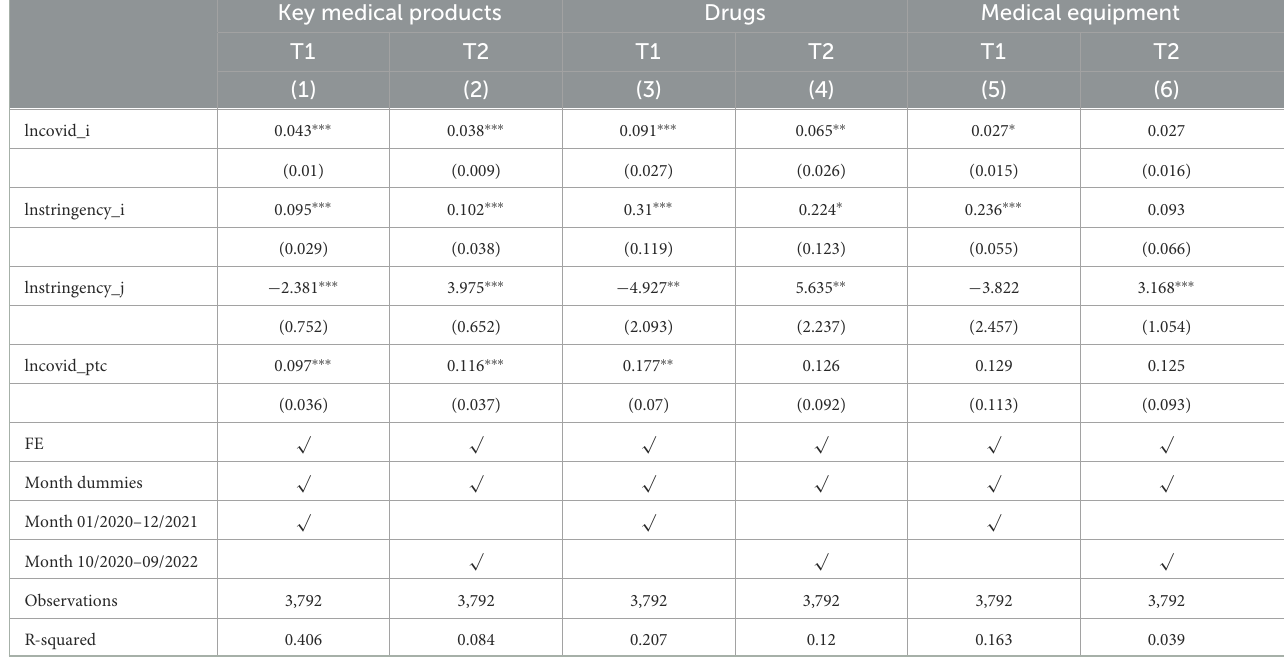
TABLE 3 Time differences.